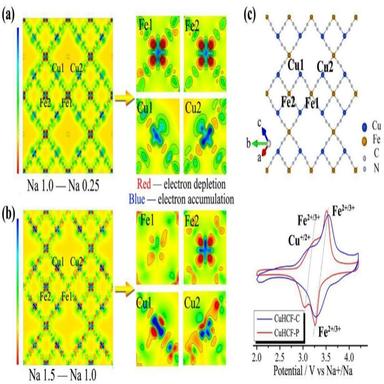
Charge density difference section along the (001) plane of CuHCF with 25% vacancies, (a) from Na-1 to Na-0.25 and (b) from Na-1.5 to Na-1. The red and blue represent electron depletion and accumulation, respectively. (c) The standard structure of CuHCF with 25% vacancies. (d) CV curves of CuHCFs: One is a stronger couple at 3.5/3.2 V as corresponds to Fe3+/2+; the other is at 3.2/3.0 V should be the redox reaction of Cu2+/+ and Fe3+/2+.